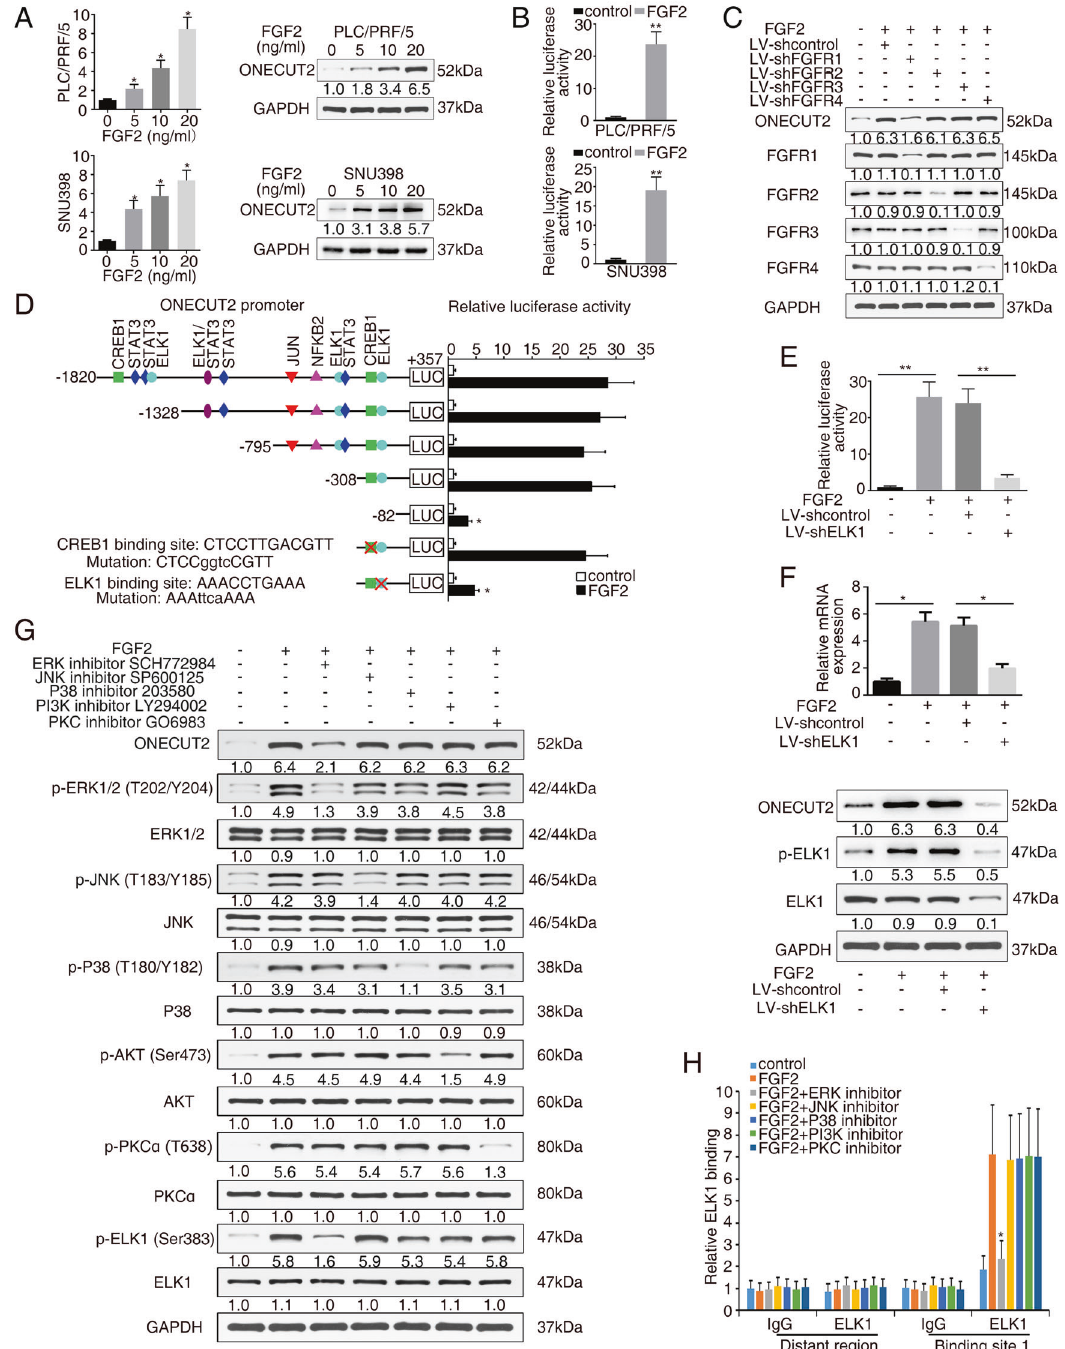
Fig. 5 FGF2 upregulates ONECUT2 expression through the FGFR1/ERK/ELK1 signaling pathway. A The levels of ONECUT2 were detected by RT-PCR and western blotting after treatment with different concentrations of FGF2 (0, 5, 10, 20 ng/ml) for 24 h. B Luciferase reporter assay showing the promoter activity of ONECUT2 in PLC/PRF/5 cells and SNU398 cells after FGF2 treatment (20 ng/ml, 24 h). C The levels of ONECUT2 were detected in PLC/PRF/5 cells after FGF2 treatment (20 ng/ml, 24 h) and FGFR1, FGFR2, FGFR3, or FGFR4 knockdown by western blotting. D The relative luciferase activity was detected in PLC/PRF/5 cells after transfection with truncations and mutated ONECUT2 promoter constructs, followed by FGF2 treatment (20 ng/ml, 24 h). E HCC cells were transfected with ELK1-silencing lentivirus, followed by FGF2 treatment (20 ng/ml, 24 h). Luciferase reporter assay showing ONECUT2 promoter activity. F RT-PCR and western blotting showing ONECUT2 levels in HCC cells transfected with ELK1-silencing lentivirus followed by FGF2 treatment (20 ng/ml, 24 h). G Protein levels of ONECUT2, ERK, p-ERK, JNK, p-JNK, P38, p-P38, AKT, p-AKT, PKC α , and p-PKC α were measured by western blotting when PLC/PRF/5 cells were pretreated with inhibitors of ERK (SCH772984, 10 μ M, 30 min), JNK (SP600125, 20 μ M, 1 h), P38 (SB203580, 20 μ M, 1 h), PI3K (LY294002, 20 μ M, 1 h) or PKC (GO6983, 10 μ M, 30 min), followed by administration of FGF2 (20 ng/ml, 24 h). H Relative binding of ELK1 to ONECUT2 promoter was determined by ChIP assays when HCC cells were treated with FGF2 (20 ng/ml, 24 h) and the indicated inhibitor. Data are mean ± SD. * P < 0.05, ** P <